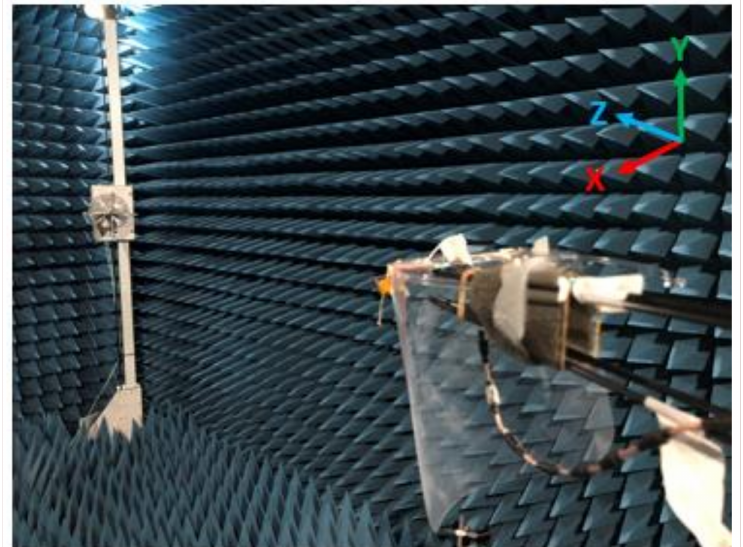
Figure 20. Photo of the erection of the medical mask in the far-field